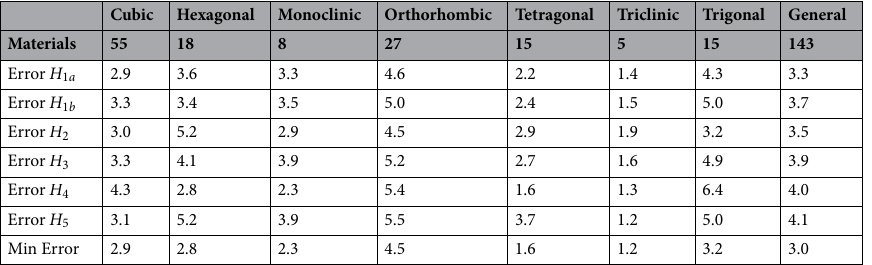
Table 1. Hardness MAE (GPa) for various materials classified by crystal system, using six different semi- empirical relations. Materials specifies the number of compounds considered for each crystal system. The Min Error value corresponds to the method that minimizes the error in each